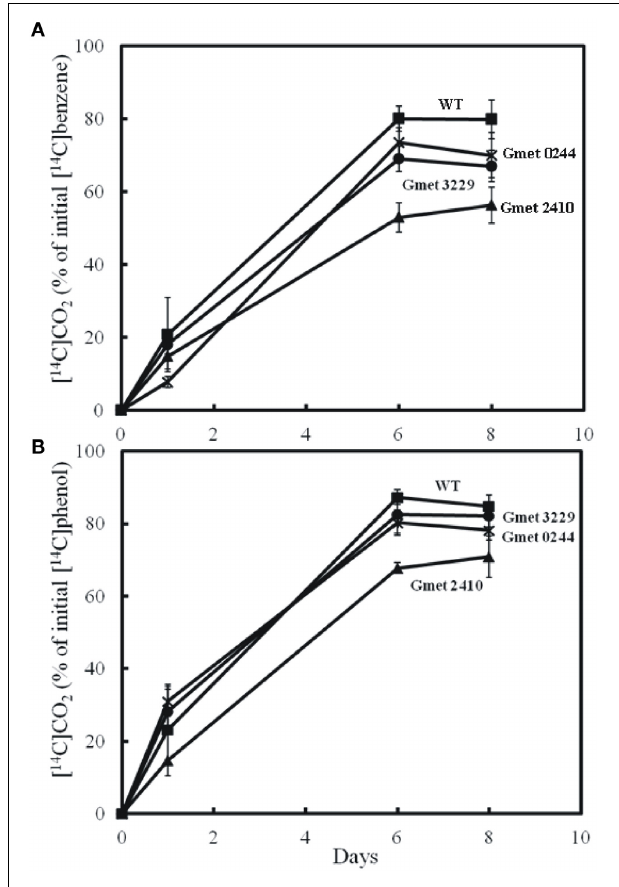
FIGURE 1 | Production of 14 CO 2 by cell suspension of strains lacking Gmet 0244, Gmet 2410, or Gmet 3229 from (A) [ 14 C]benzene or (B) [ 14 C]phenol. The results are the mean and standard deviation for triplicate cell suspensions.